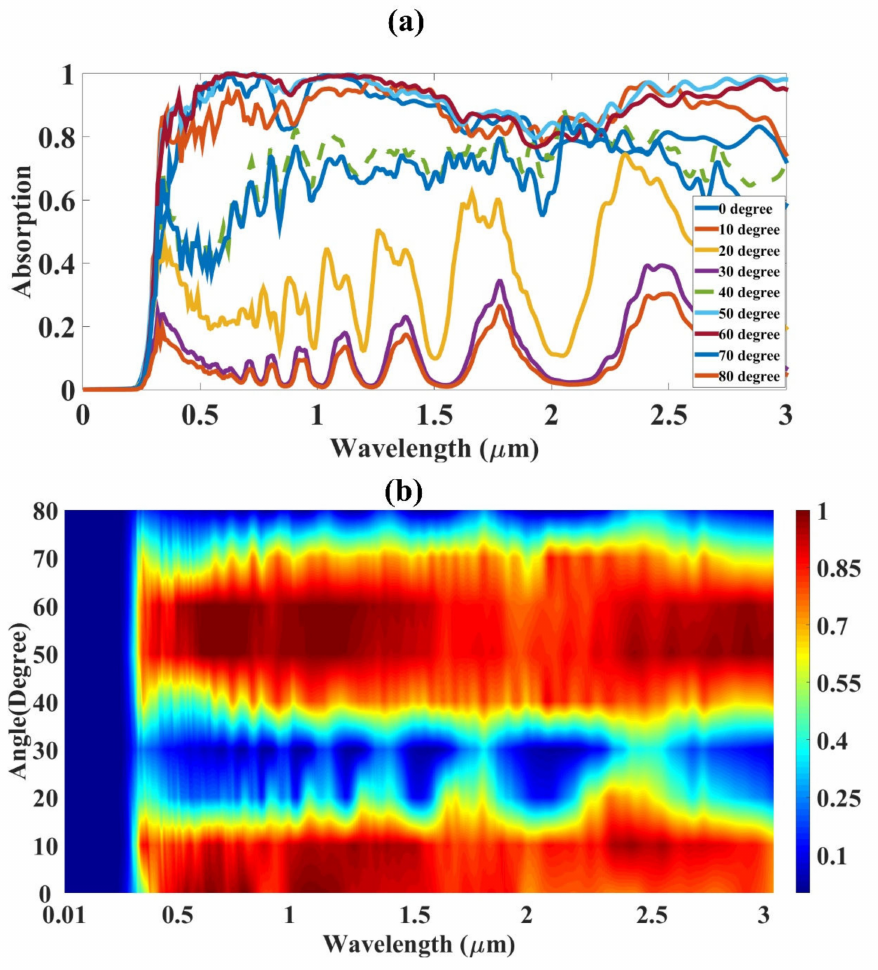
Figure 8. Angular response for 0 to 3000 nm range. ( a ) Line, ( b ) color plots for 0 to 80-degree angular